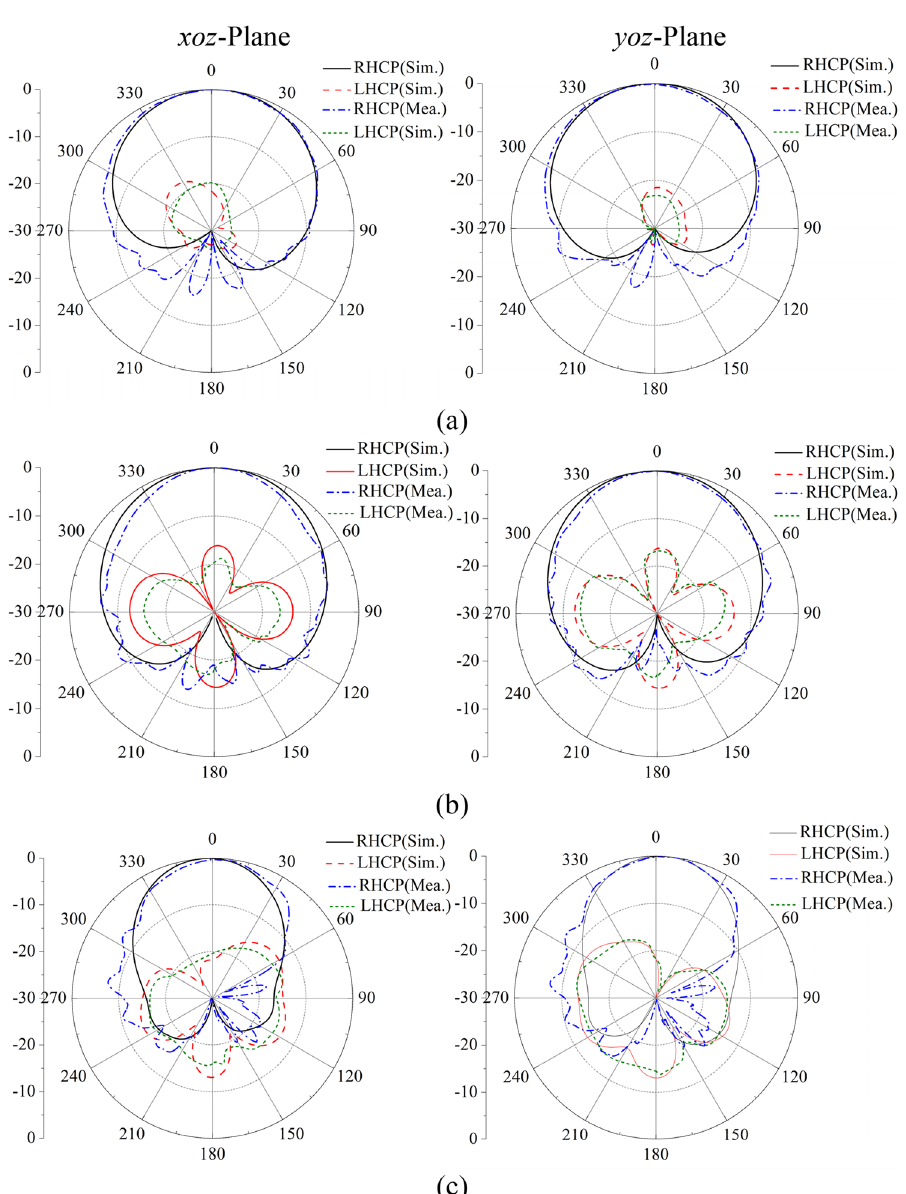
Figure 10. Simulated and measured radiation patterns of the prototype. ( a ) 3.3 GHz. ( b ) 4 GHz. ( c ) 6.7